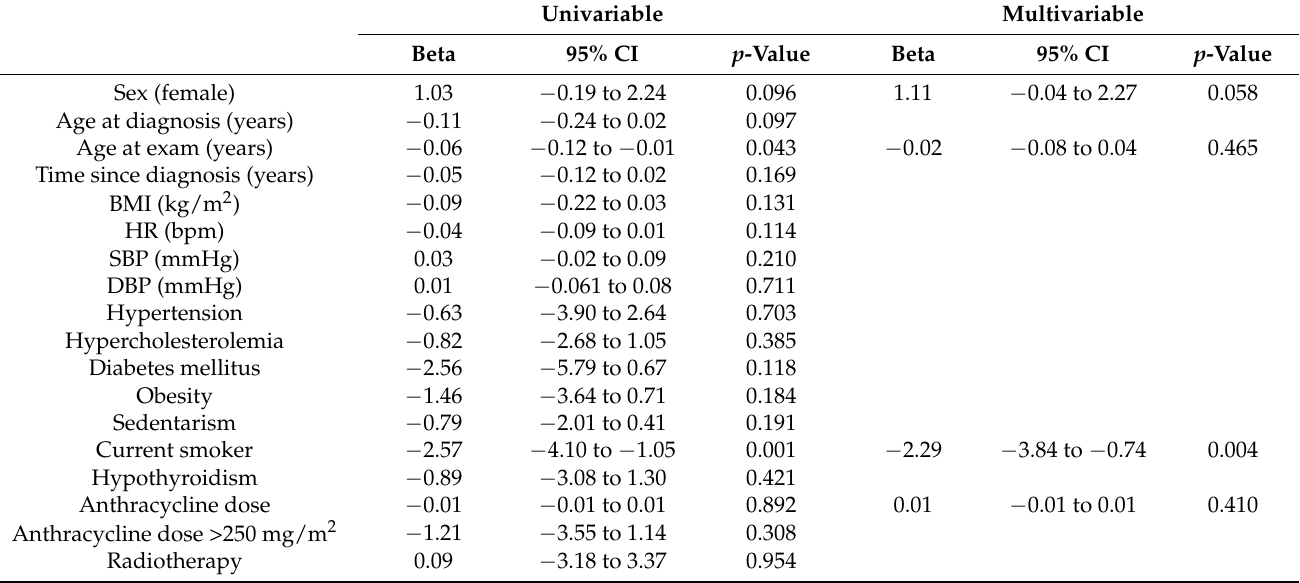
Table 4. Univariable and multivariable linear regression models for GLS in